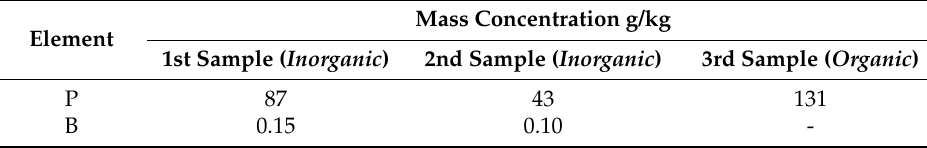
Table 4. Concentration of P and B in the